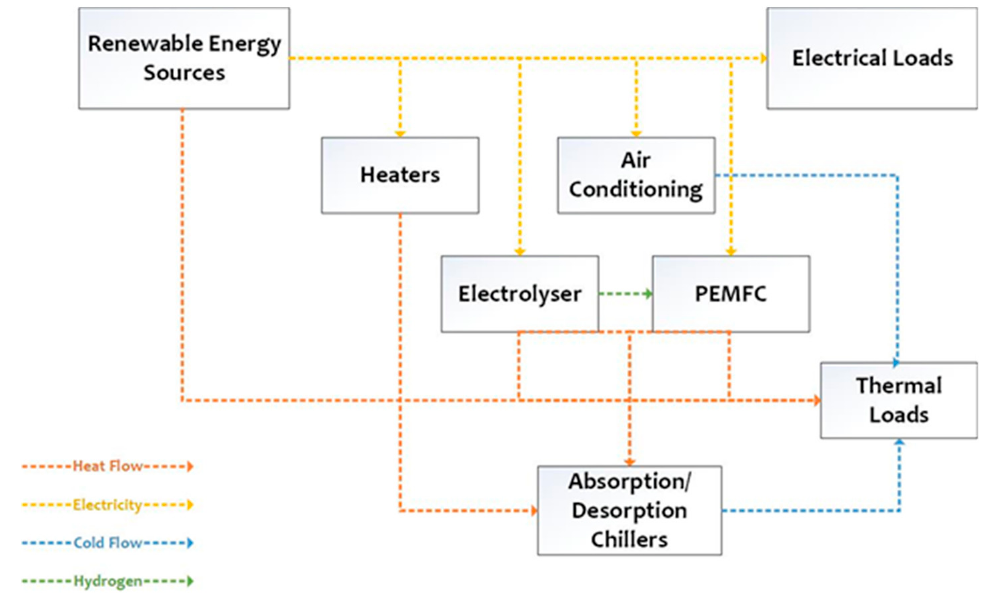
Figure 5. A flowchart of a tri-generation system based on a fuel cell (adapted from [16]).